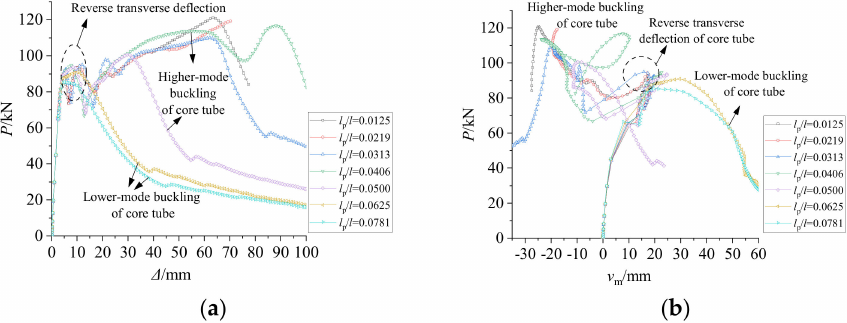
Figure 14. Effect of core protrusion l p : ( a ) P - ∆ relationships; ( b ) P - v m